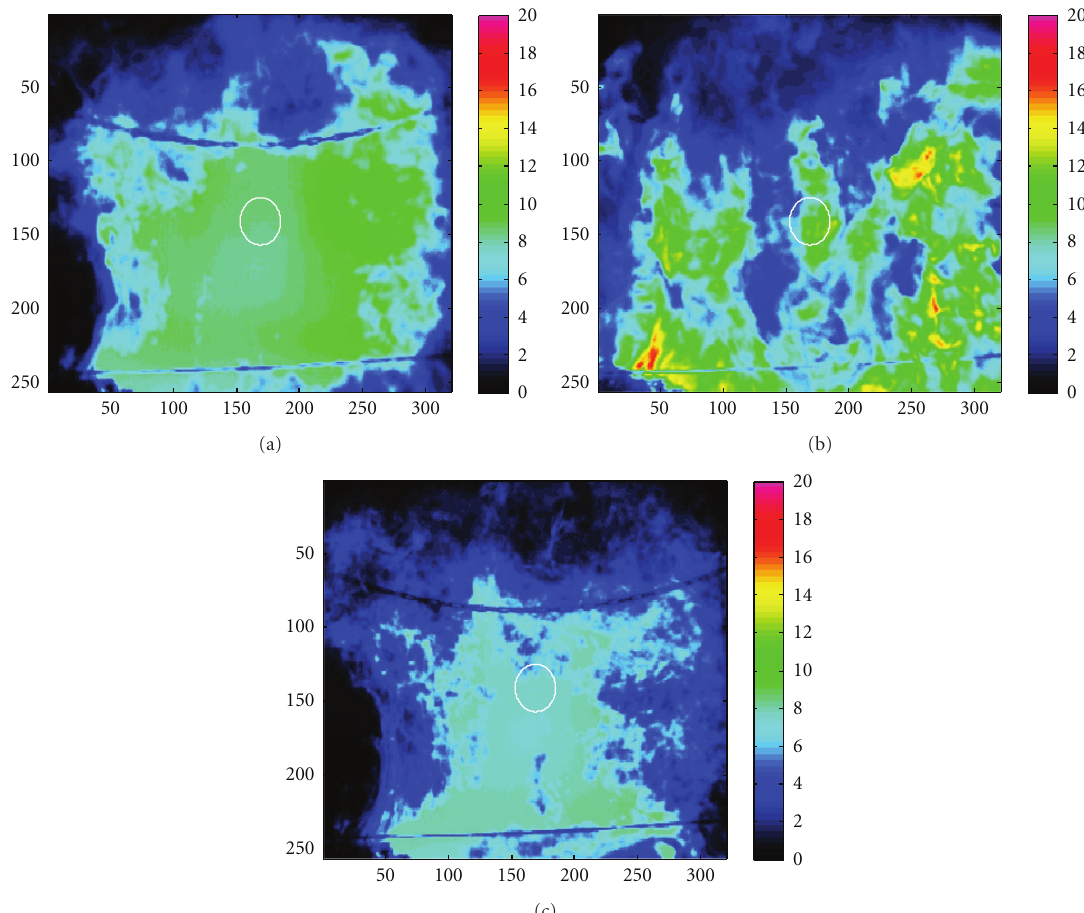
Figure 3: Flames generated by the burning of the 2m long WS fuel bed: camera acquisitions in the emission bands of CO 2 (a), H 2 O (b), and soot (c). Color bar indicates spectral intensity in W/m 2 · sr · cm − 1 . The white circle delimits the observation area of the spectrometer. The fuel load is 1kg/m 2